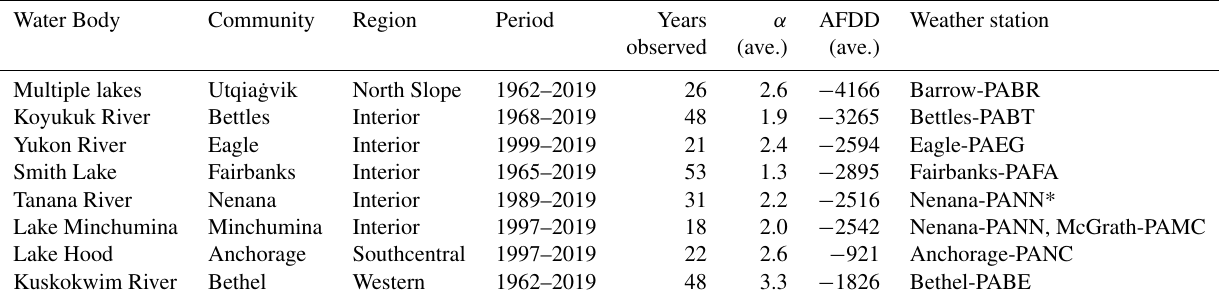
* Missing data derived from relationship to